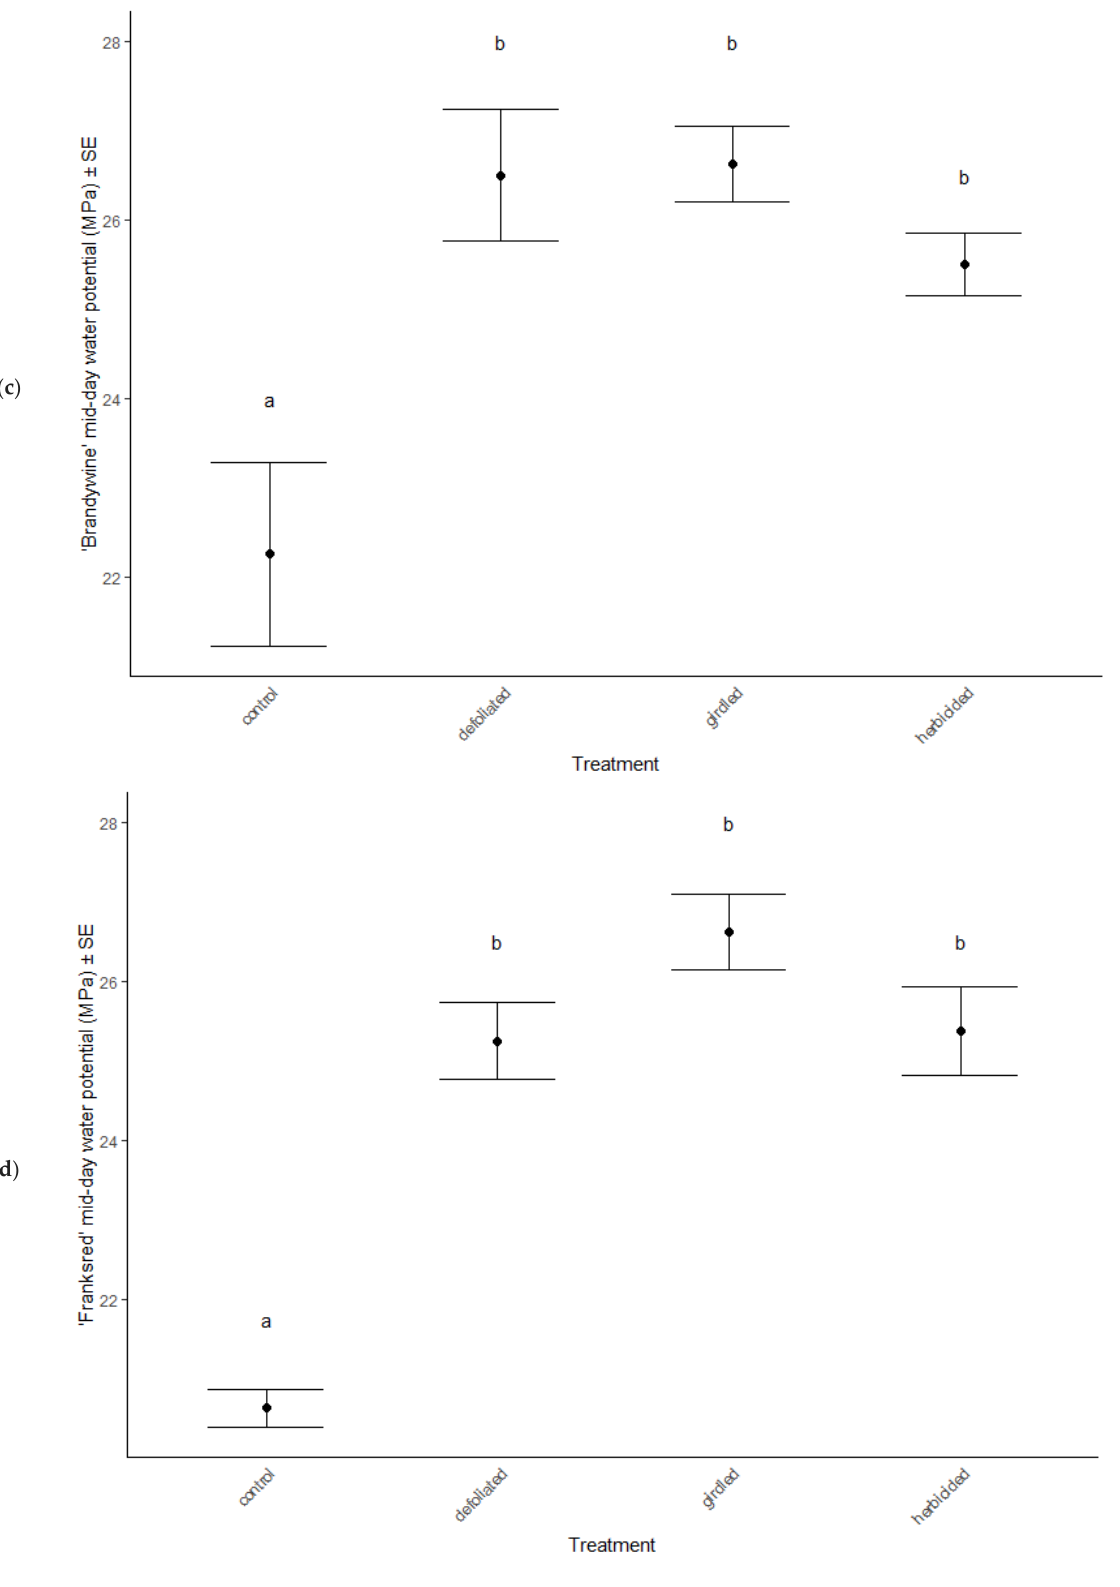
Figure 4. Water potential (MPa) of control and stressed treatments of ‘Brandywine’ ( a ) pre ‐ dawn and ( b ) mid ‐ day, and ‘Franksred’ ( c ) pre ‐ dawn and ( d ) mid ‐ day cultivars of red maples ( Acer rubrum ). Different letters represent statistical differences between treatments according to a post hoc Tukey HSD analysis.